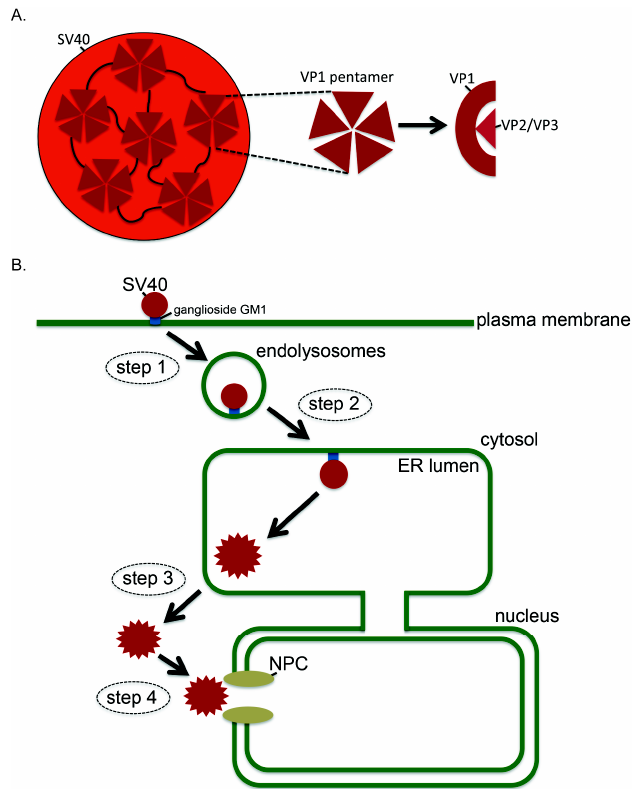
Figure 1. Simian virus 40 (SV40) structure and entry pathway. ( A ) SV40 consists of 360 VP1 copies arranged as 72 pentamers, which are localized on the viral surface. The pentamers are stabilized by disulfide bonds, as well as by interactions between the VP1 carboxy-terminus, which invades a neighboring pentamer (black curved lines). VP1 also binds to the underlying internal hydrophobic proteins VP2 and VP3. ( B ) To infect cells, SV40 interacts with the glycolipid receptor ganglioside GM1 on the plasma membrane, internalizes, and traffics to the endolysosomes (step 1). The virus then targets to the endoplasmic reticulum (ER) using a lipid-sorting mechanism (step 2), from where it crosses the ER membrane to access the cytosol (step 3). Upon entering the cytosol, SV40 mobilizes into the nucleus (step 4), where ensuing transcription and replication of the viral genome causes lytic infection or cellular transformation. NPC: nuclear pore